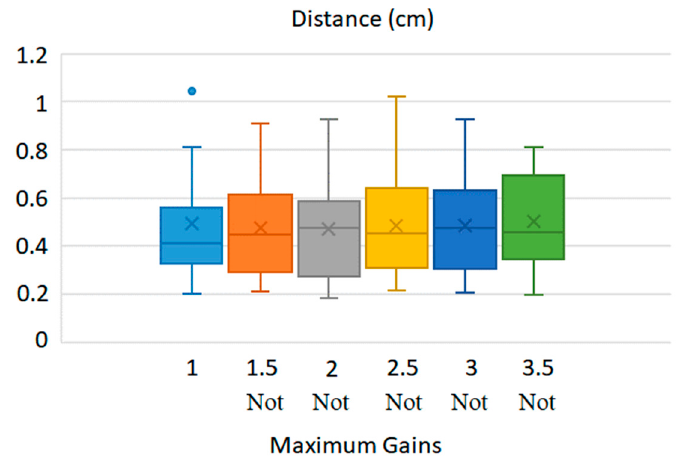
Figure 5. Error distances based on the maximum CD gains. Table 3. Mean error distances with standard deviation